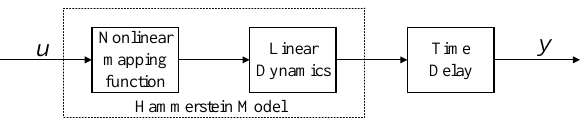
Figure 3. Modified Hammerstein